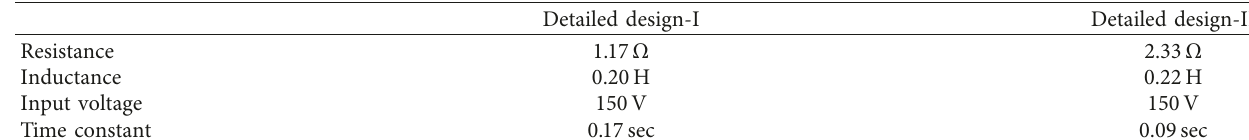
Table 3: Analysis results of suggested actuator.